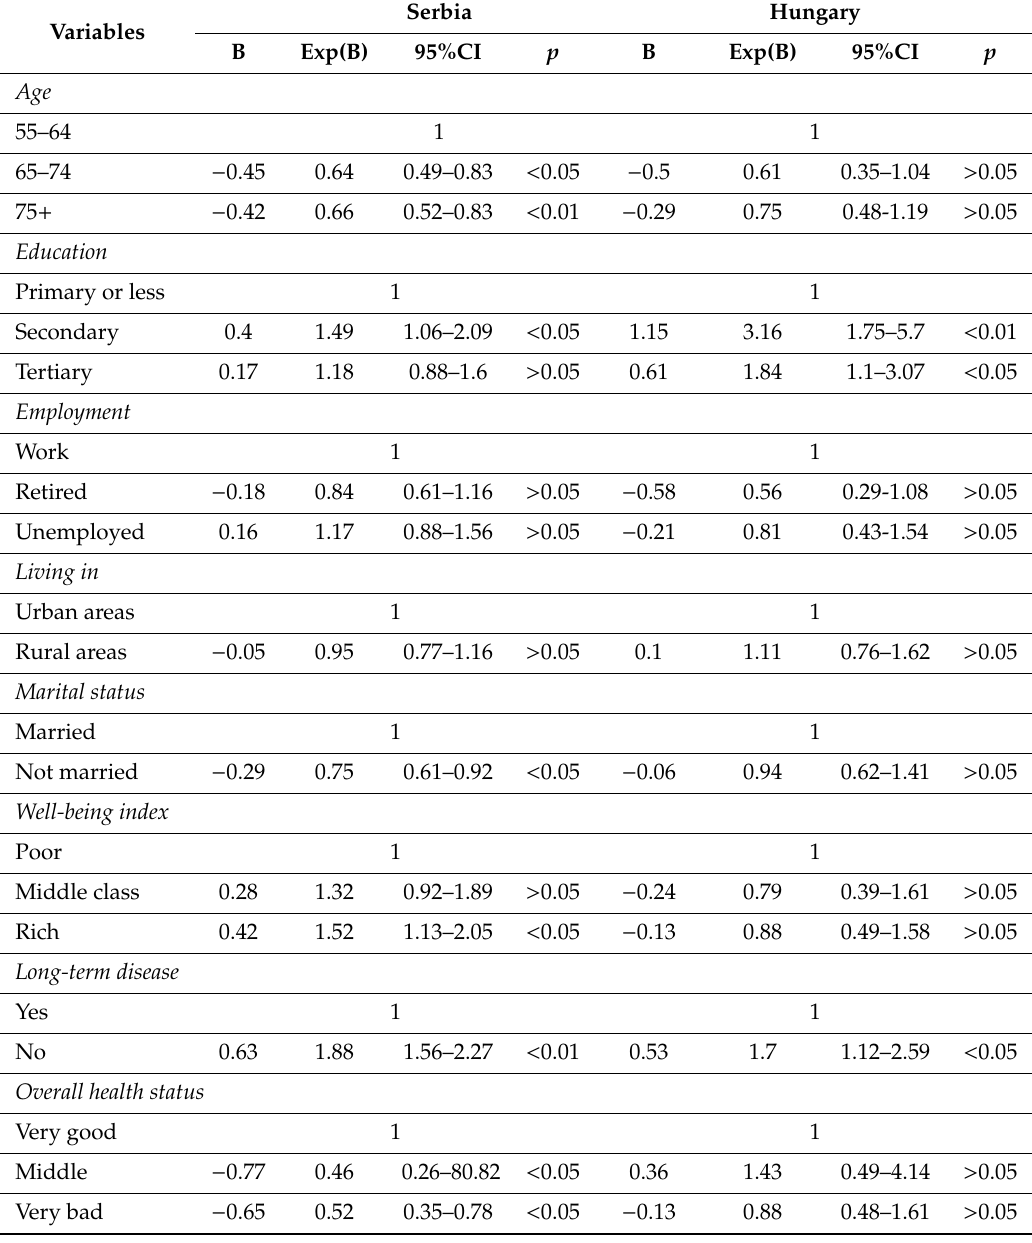
Table 3. Binary logistic regression for alcohol consumption among older men in Serbia and Hungary.